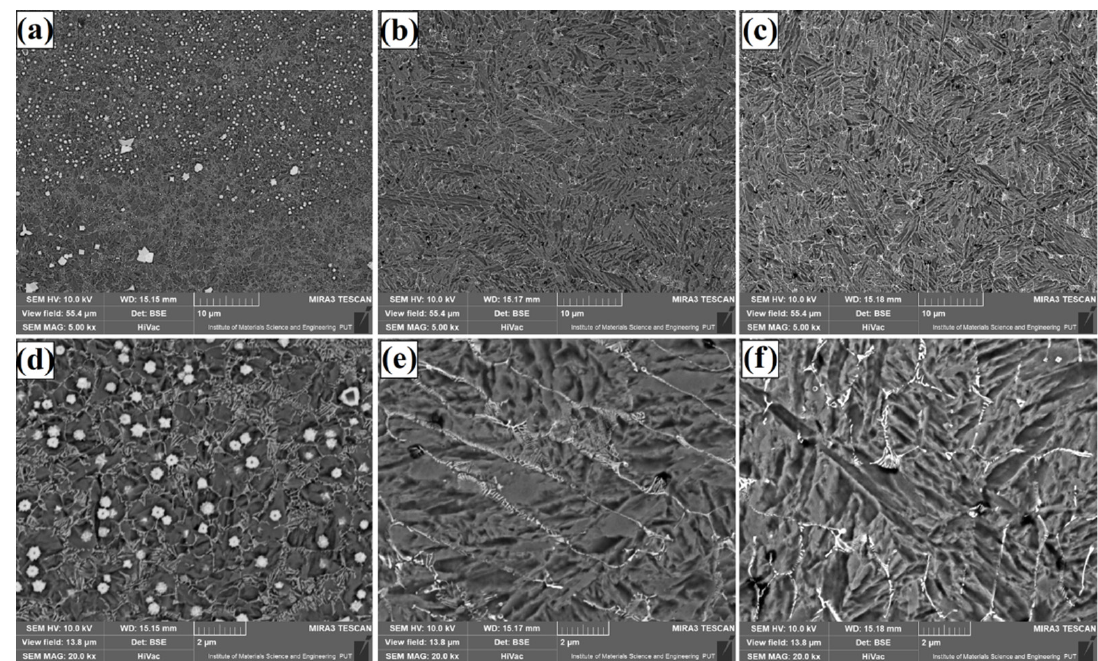
Figure 10. Subsurface area of the Fe/TaC coatings produced on tool steel using 90 µm thick pre-coat and laser beam power of 500 W ( a , d ), 800 W ( b , e ), 1100 W ( c , f ).